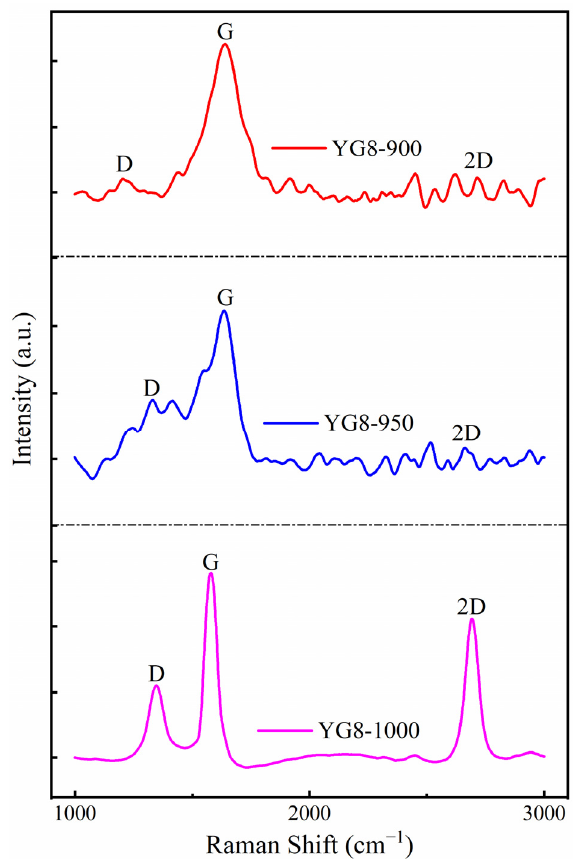
Figure 5. The Raman spectra at different growth temperatures.